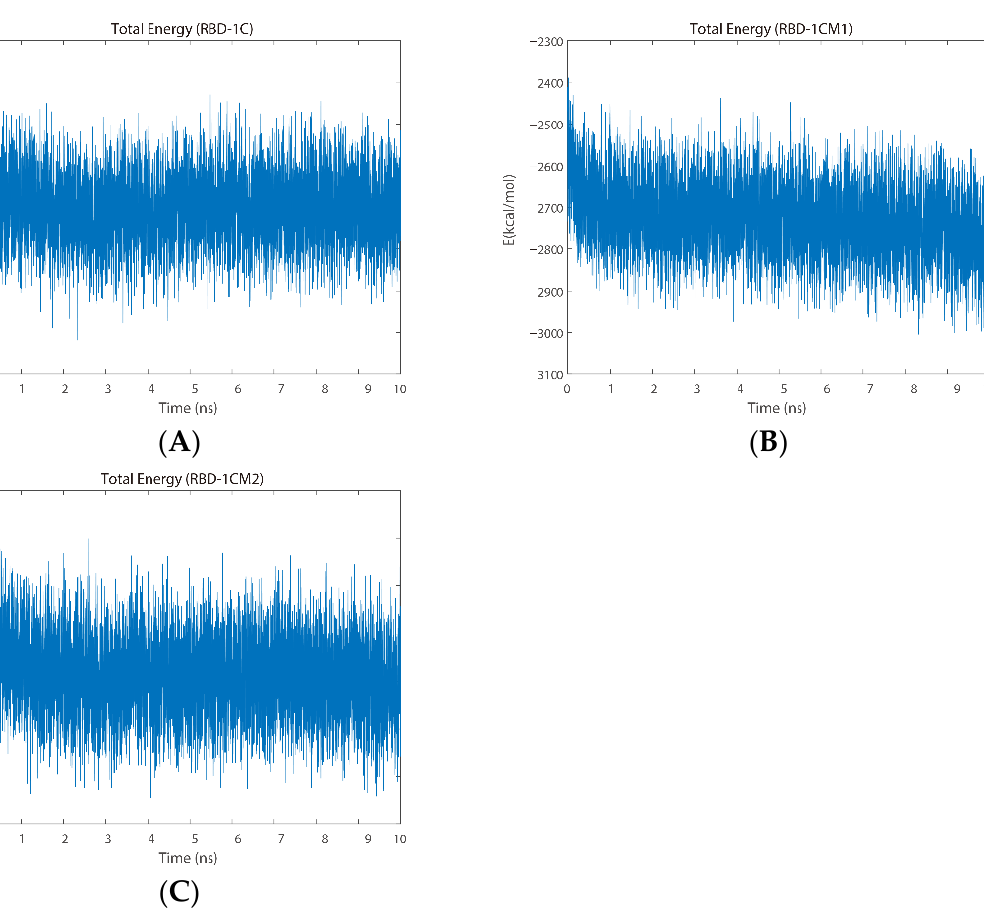
Figure 4. Total energy plots for ( A ) the S protein/RBD-1C complex, ( B ) S protein/RBD-1CM1 complex, and ( C ) S protein/RBD-1CM2 complex during the MD simulation.